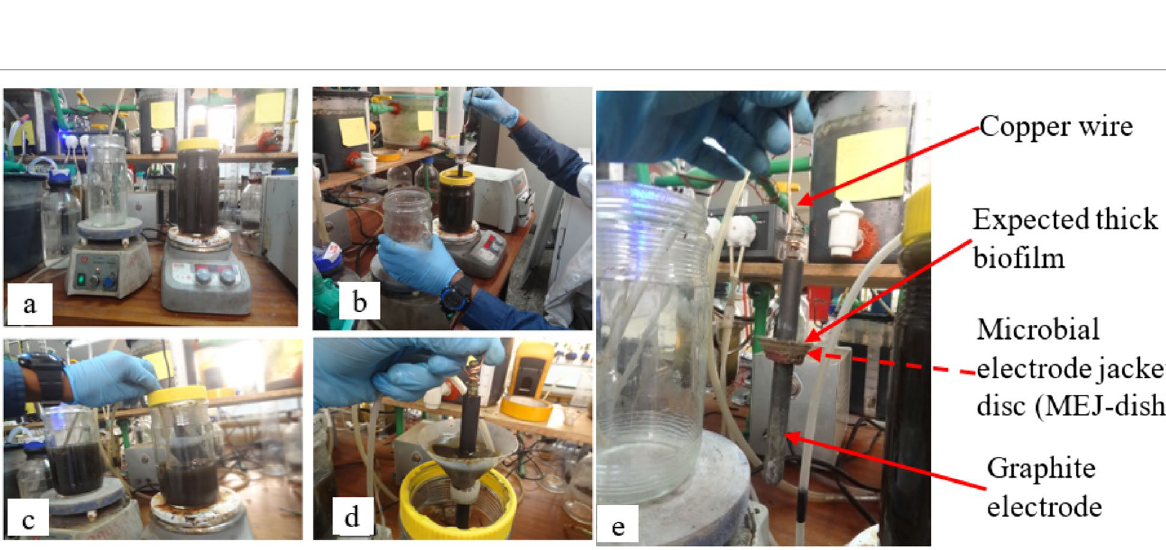
Fig. 4 Fragmented electro-active biofilm (FAB) reactor conceptual scheme a raw domestic wastewater and inoculum fed into the reactor, b microbial electrode jacket dish (MEJ-dish) inserted to the graphite electrode, c pumping wastewater from the reactor, d removing the electrode, and e solid mass collected on the